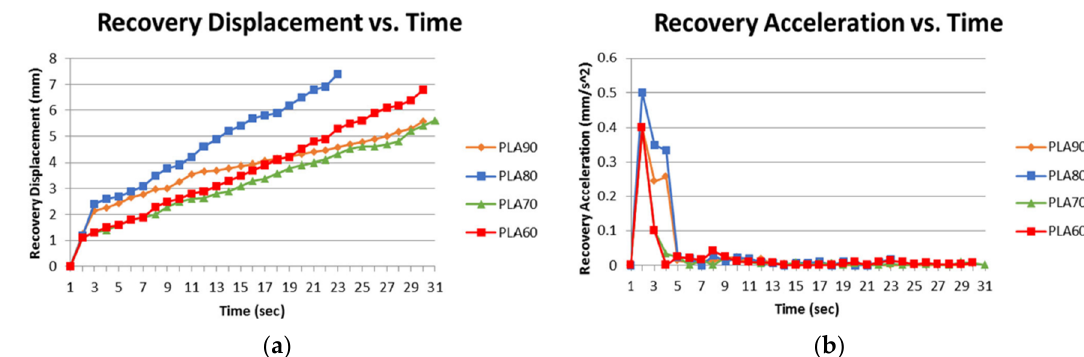
Figure 6. ( a ) Dynamic recovery displacement against time; ( b ) dynamic recovery acceleration against time [75].